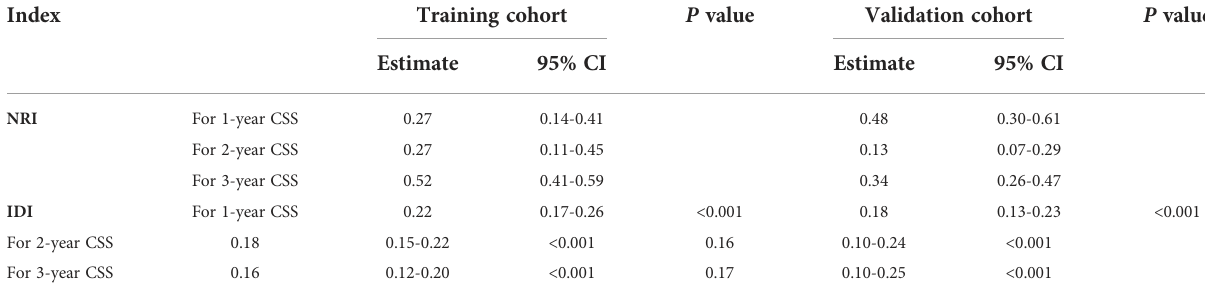
TABLE 3 NRI and IDI of the nomogram and AJCC staging criteria alone in CSS prediction for ECCA.